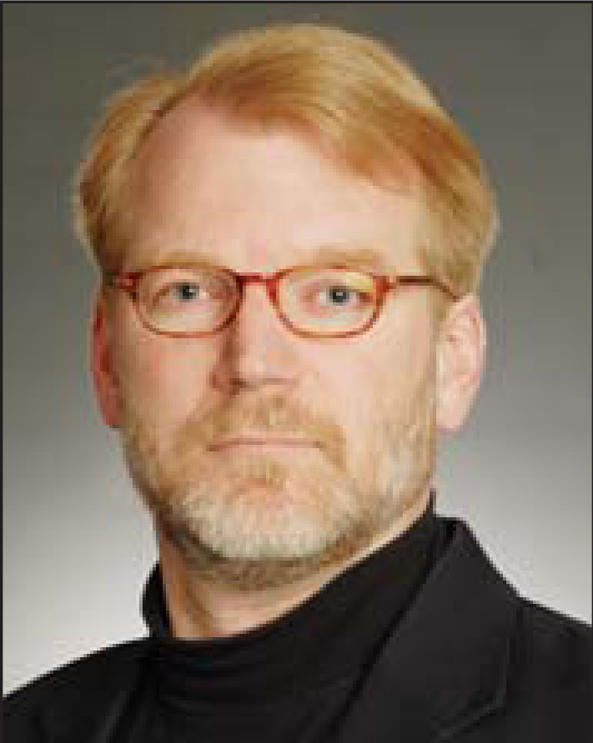
Bruce P. Lanphear